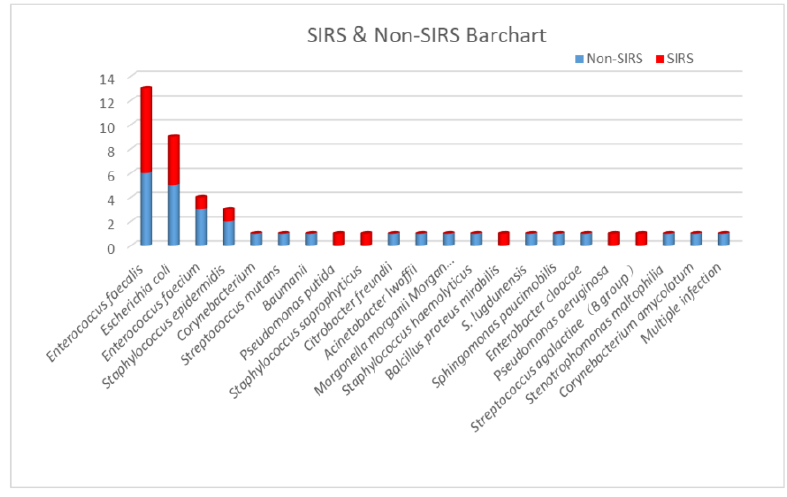
Figure 2. The proportion of post-PCNL SIRS in patients with different bacterial strains in urine cultures.